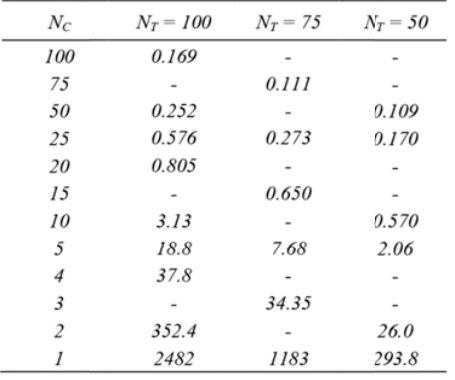
Fig. 5. Sum against the transforma approxima Tab